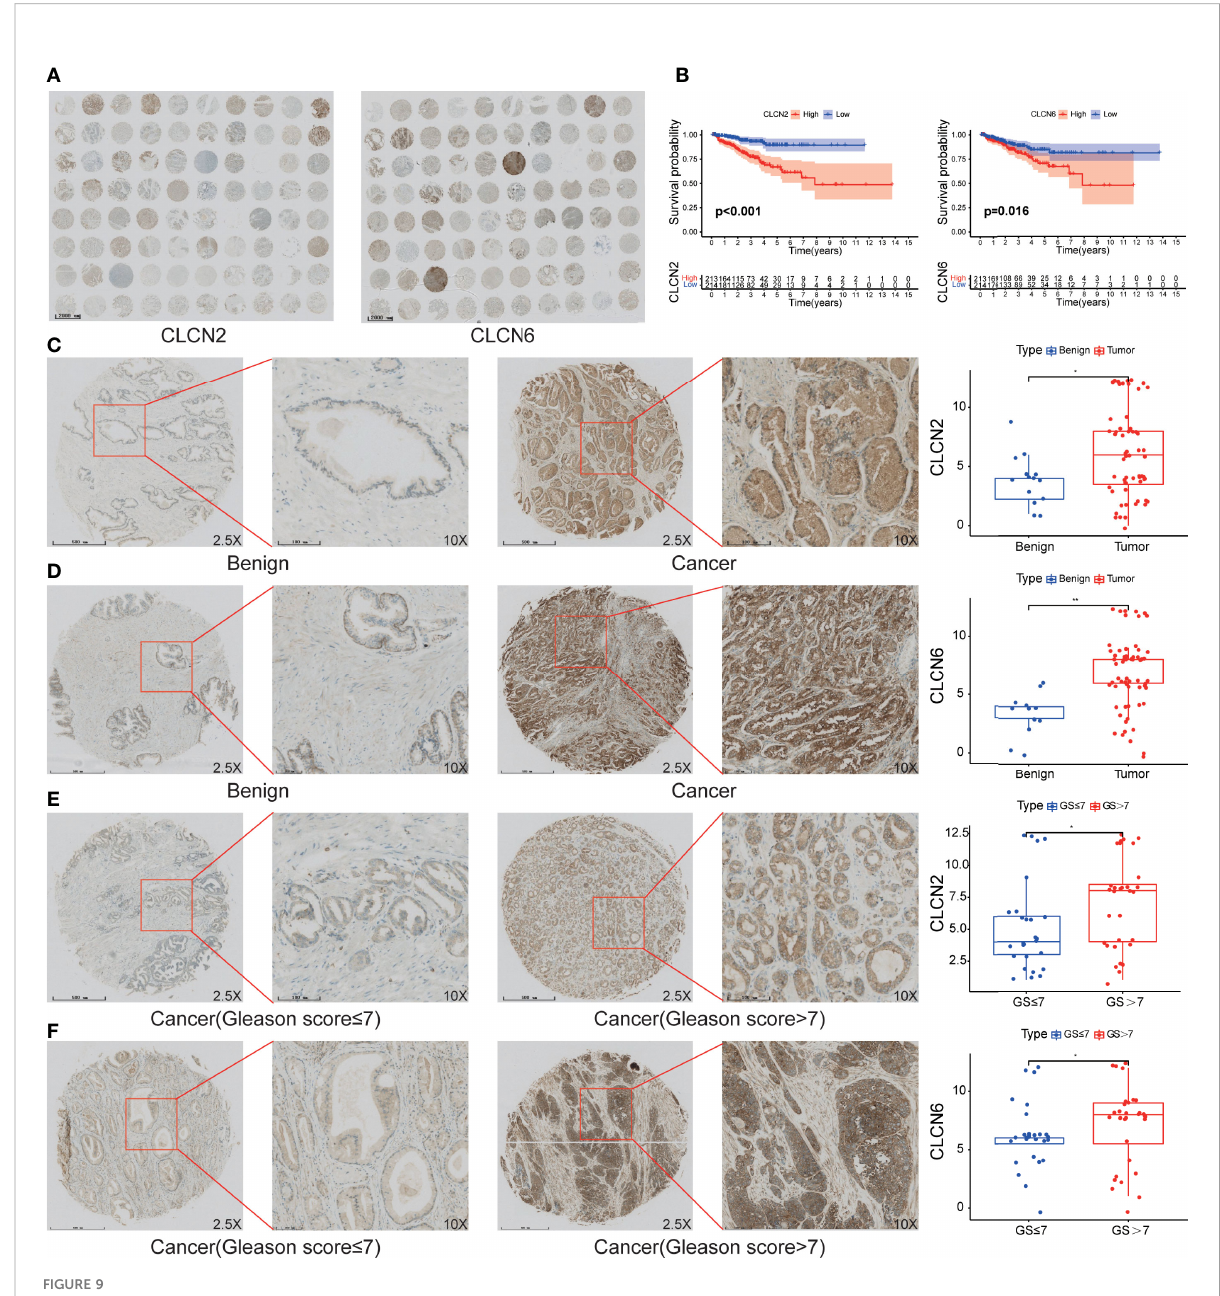
FIGURE 9 The expression patterns of core genes and the connection to PCa progression. (A) The overall view of CLCN2 and CLCN6 based on IHC analysis. (B) Kaplan-Meier survival of BCR based on CLCN2 and CLCN6 expression from TCGA database. IHC of TMA revealed (C) CLCN2 and (D) CLCN6 were upregulated in PCa. Greater (E) CLCN2 and (F) CLCN6 stainings were related to higher Gleason score (GS). * p<0.05 and **